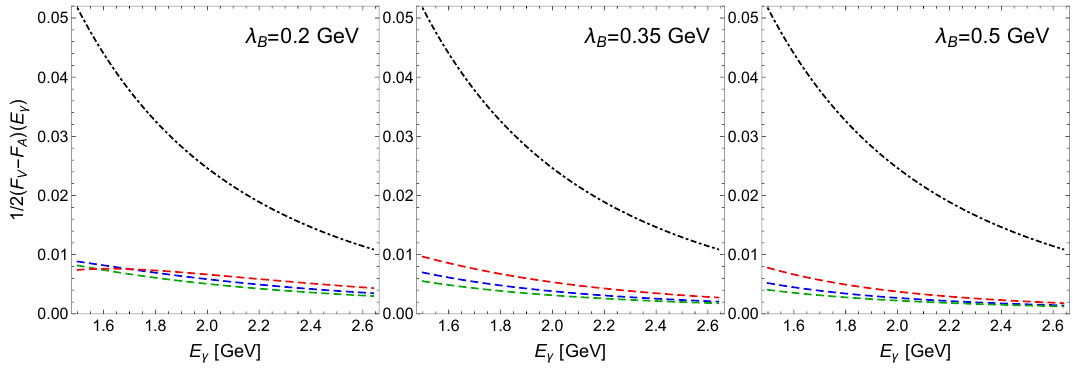
Figure 6 . Model-independent higher-twist [9] (black dash-dotted curves) and soft (dashed curves) contributions to the form factor di(cid:11)erence (1 = 2)( F V (cid:0) F A ) for three choices of (cid:21) B . The soft cor- rections are shown for (cid:27) 1 = (cid:0) 0 : 69 ; 0 ; +0 : 69 in red, green and blue colour, respectively. The colour b coding corresponds to (cid:12)gure